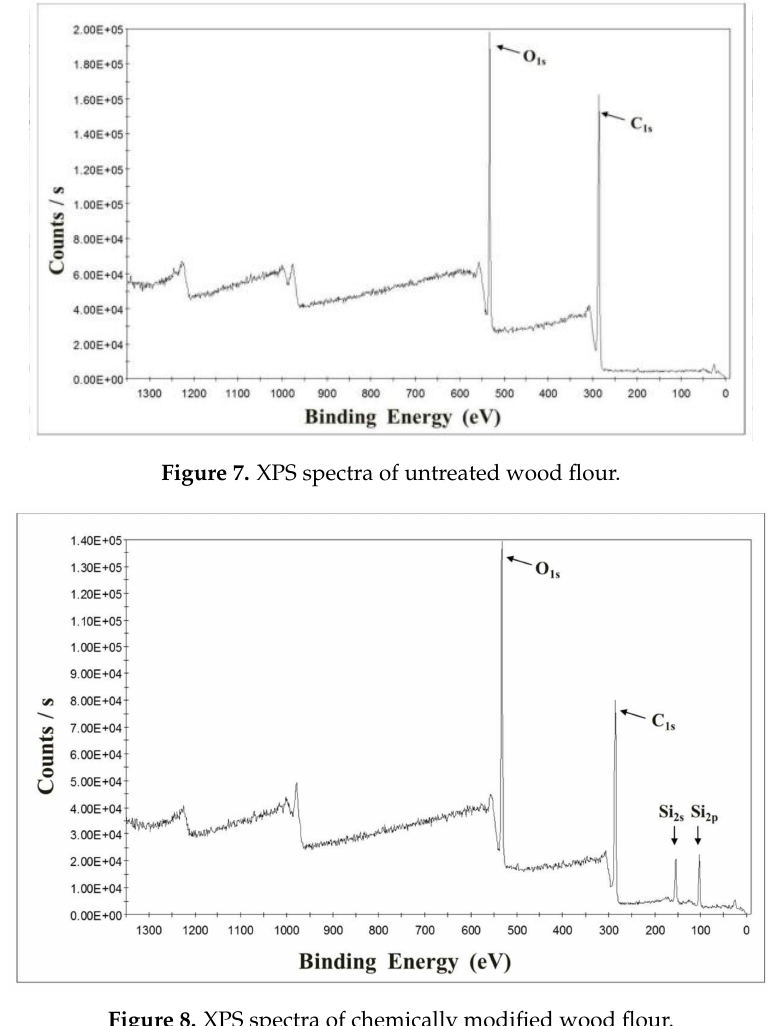
Figure 8. XPS spectra of chemically modified wood flour. Table 4. The surface elemental composition ratio of untreated wood flour and chemically modified wood flour by XPS